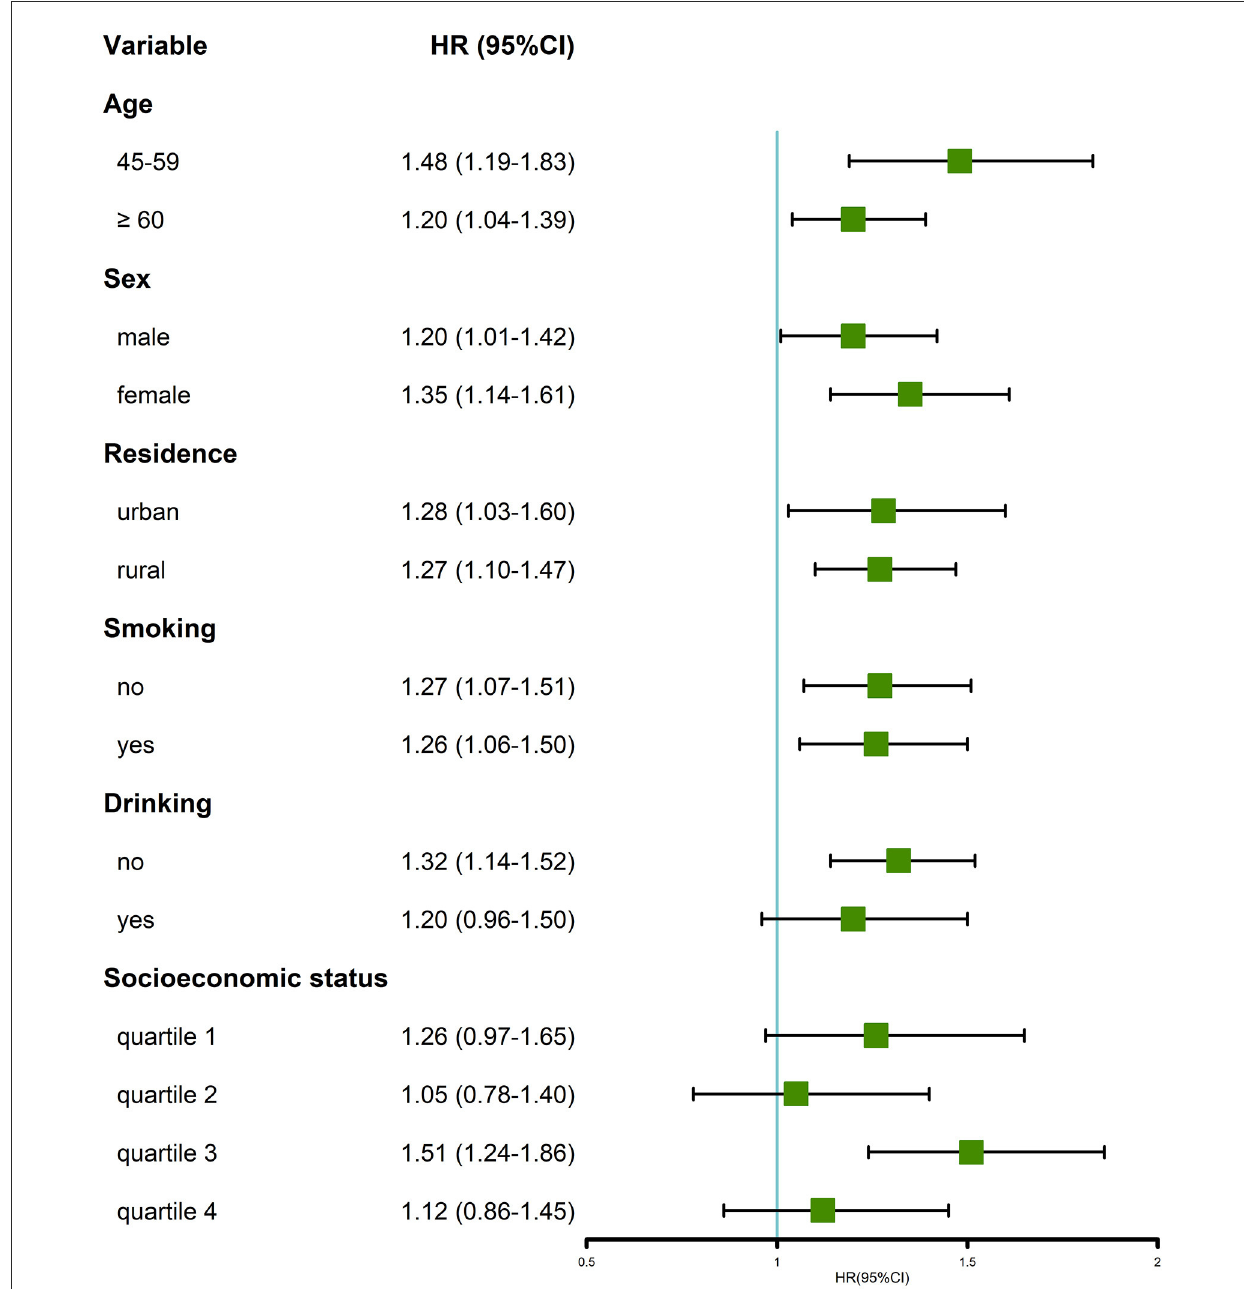
FIGURE4 Stratified analysis of the HRs between multimorbidity and memory-related